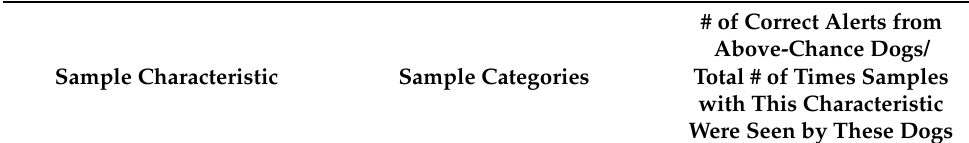
Table A2. Canine Test Trial Results- Response to COVID-19 Positive Samples.